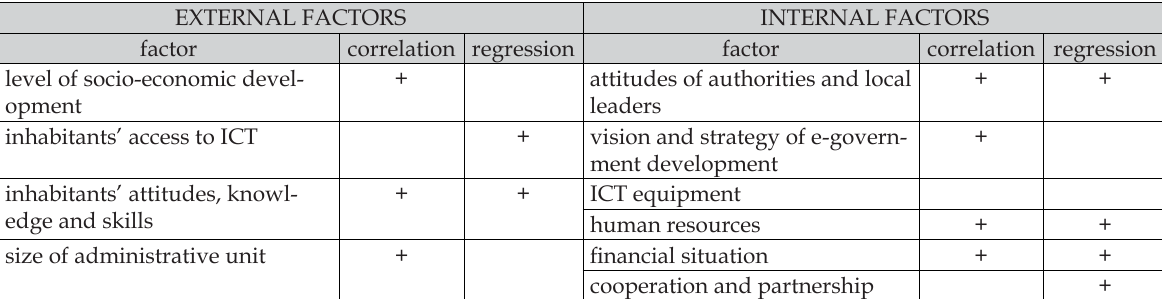
Table 2. Factors of local e-government development in the communes of the Poznań agglomeration EXTERNAL